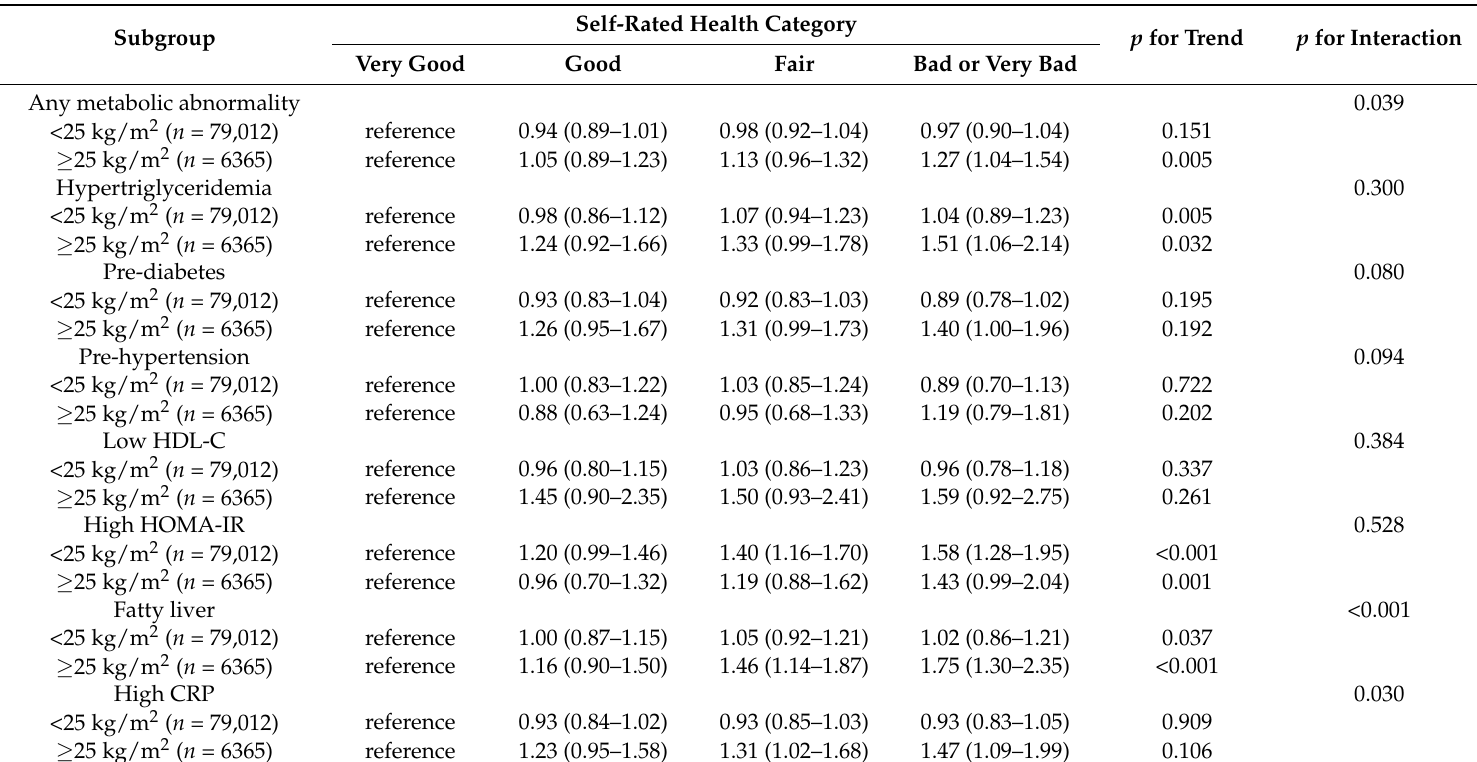
Table 4. Hazard ratios (95% CI) of development of each metabolic abnormality according to self-rated health category and